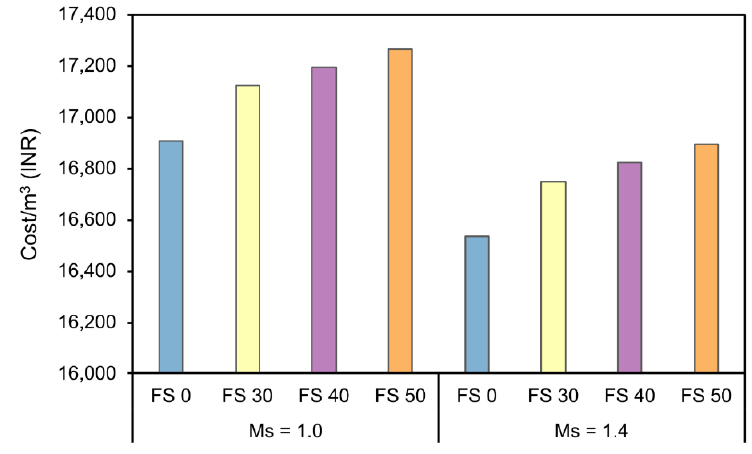
Figure 31. Cost estimate of AAC in the Indian context.